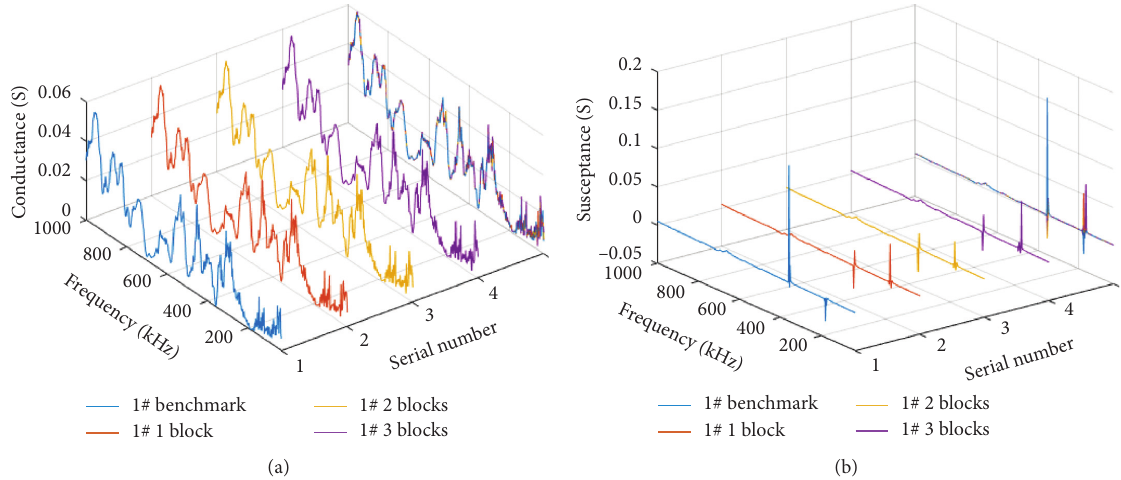
Figure 8: (a) The conductance and (b) the susceptance of 1# undamaged PZT when the structure is in healthy and different severe damage conditions.